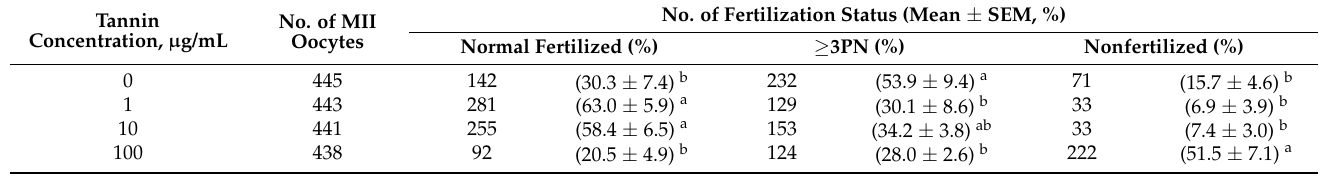
Table 3. Effects of tannin on polyspermic penetration incidence in porcine oocytes.